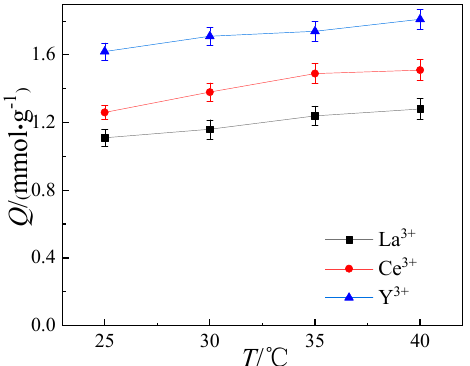
Figure 7. E ff ect of temperature. ( C 0 = 0.01 mol · L − 1 , t = 6 h; pH values for La 3 + , Ce 3 + , and Y 3 + were 2.0, 1.0, and 3.0, Figure 7. Effect of temperature. ( C 0 = 0.01 mol·L − 1 , t = 6 h; pH values for La 3+ , Ce 3+ , and Y 3+ were 2.0, 1.0, and 3.0, respectively).